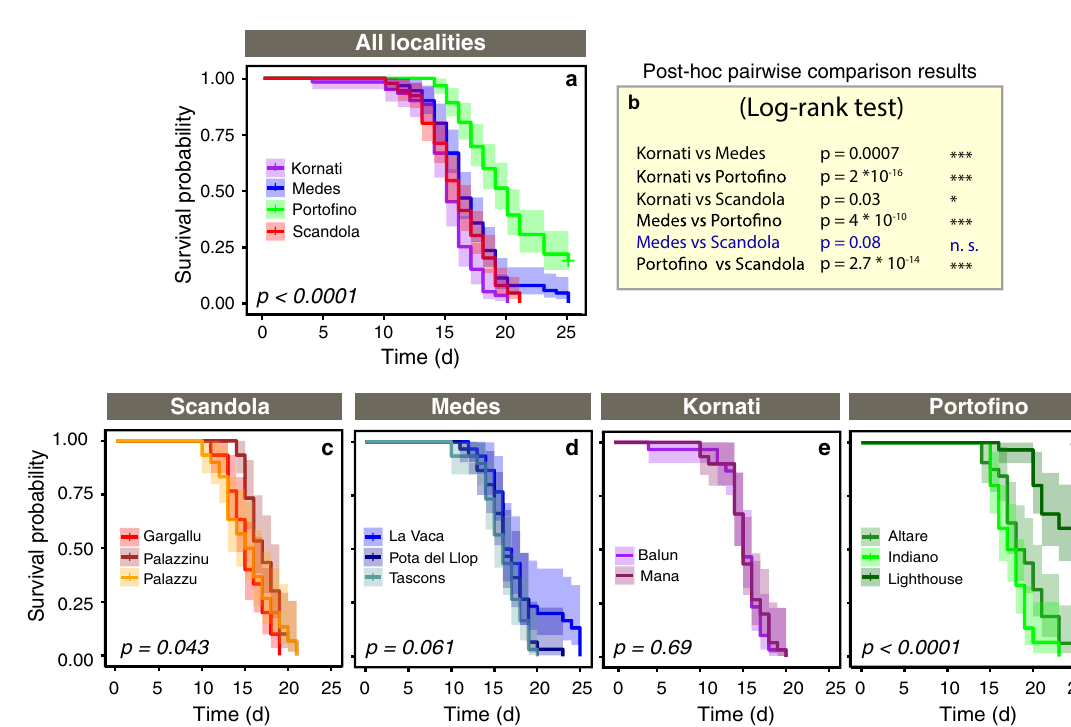
Figure 4. ( a ) Differences in survival probability across localities in P. clavata when exposed to thermal stress. ( b ) Post-hoc pairwise comparison across localities. ( c – f ). Differences in survival probability across populations (within